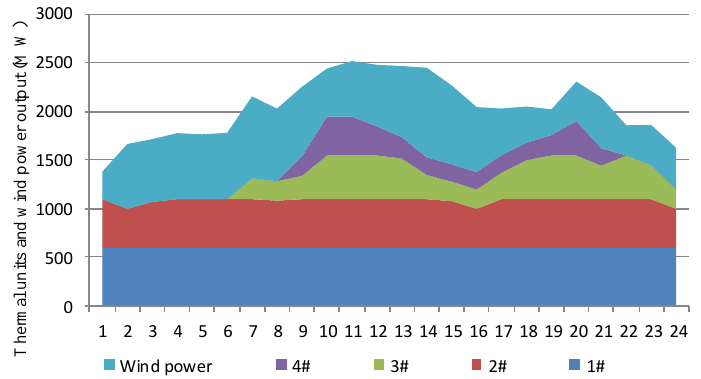
Figure 7. Thermal units and wind power output in Case